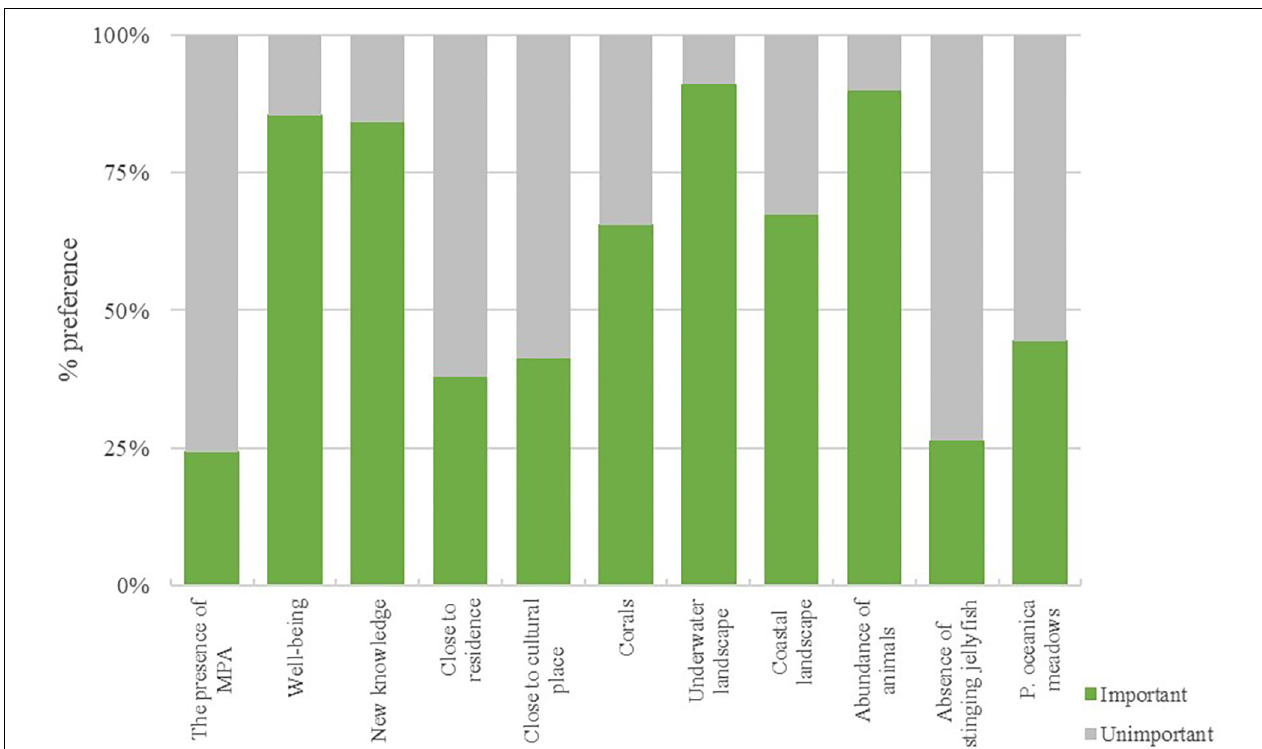
FIGURE 2 | Percentages of diver preferences among different features determining the choice of a dive experience location. The green bars represent the responses classified as important and very important, while the gray bars represent the responses classified as unimportant and very unimportant.